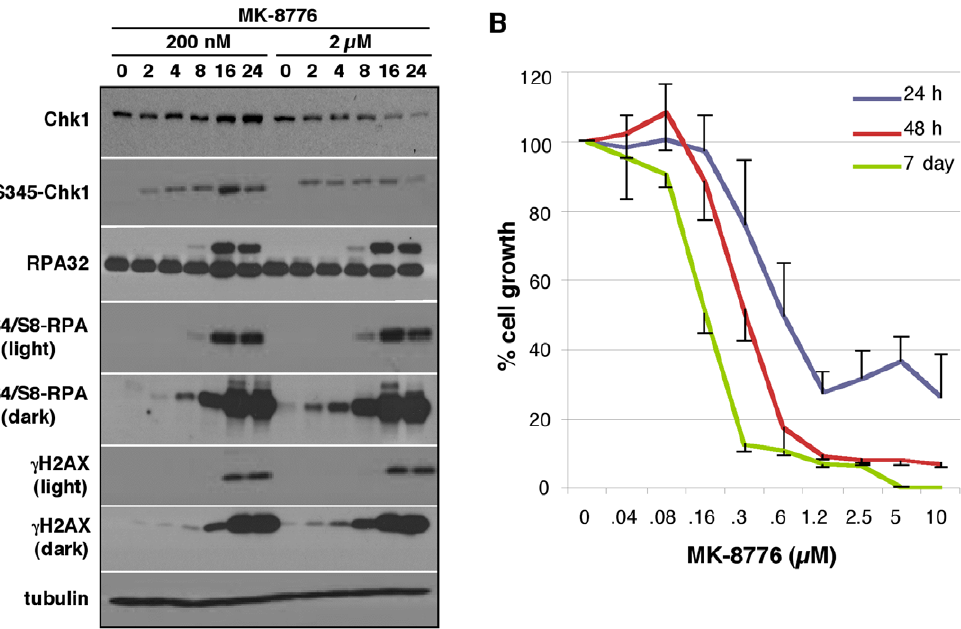
Figure 1. MK-8776 induces DNA damage and S phase arrest in U2OS cells. A. Cells were incubated with 200 nM or 2 m M MK-8776 for 0– 24 h then analyzed by western blotting for markers of DNA damage. B. Cells were incubated with MK-8776 for 24 h or 48 h then allowed to recover in drug-free media, or incubated continuously for 7 days with MK-8776. Total DNA content per well was then assessed as a measure of cell growth. Error bars (shown only in one direction for clarity) represent the standard error of 3 independent experiments.